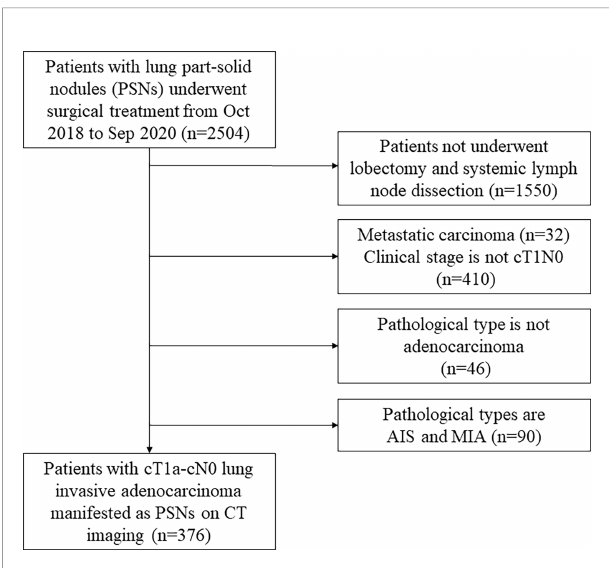
FIGURE 1 | The fl ow diagram of the patient selection. PSN, part-solid nodule; AIS, adenocarcinoma in situ; MIA, microinvasive